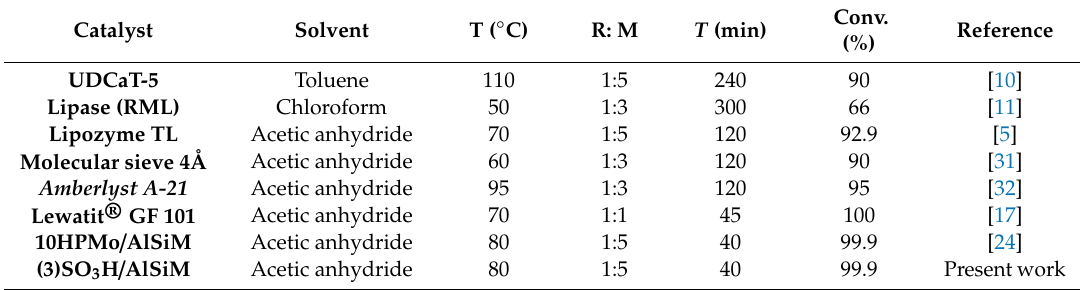
Table 5. A comparison of literature results for the conversion of Eugenol over various